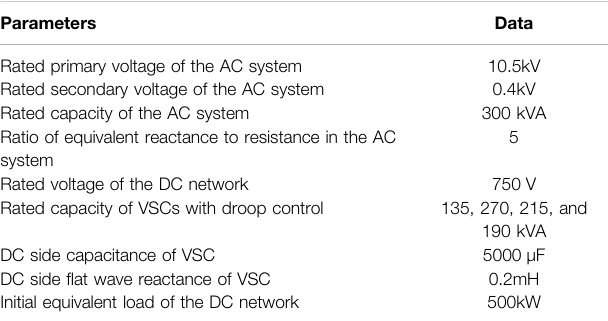
TABLE 2 | Parameters of response characteristic analysis.